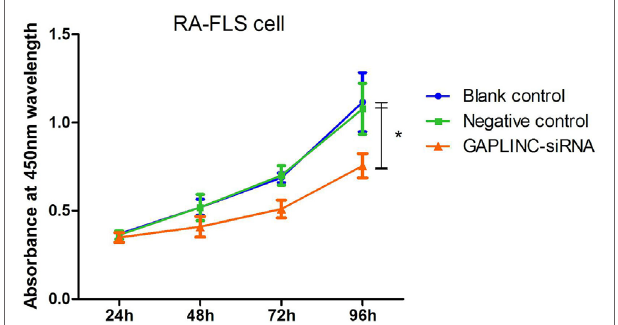
FigUre 2 | Knocking-down GAPLINC in rheumatoid arthritis-fibroblast-like synoviocytes decreases cell proliferation. Cell growth was measured using a cell counting kit-8 assay. The absorbance at 450 nm wavelength of GAPLINC- small interference RNA group were significantly reduced at 24, 48, and 72 h, largely maintained at 96 h compared to two control groups, * P < 0.05.